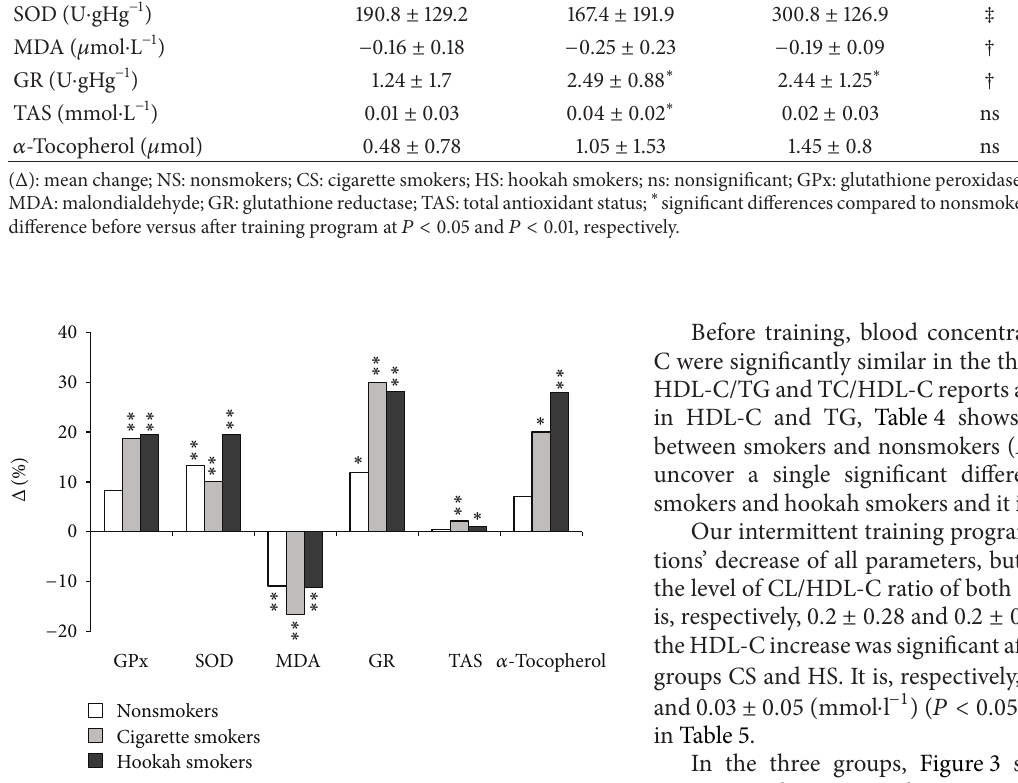
Figure 2: Antioxidants improvement rate in percentage of the three groups after training program. GPx: glutathione peroxidase; SOD: superoxide dismutase; MDA: malondialdehyde; GR: glutathione reductase; TAS: total antioxidant status; ∗ 𝑃 < 0.05 ; ∗∗ 𝑃 < 0.01 ; ∗∗∗ 𝑃 < 0.001